Question: Reading the figure, is the described quantity rising or falling?
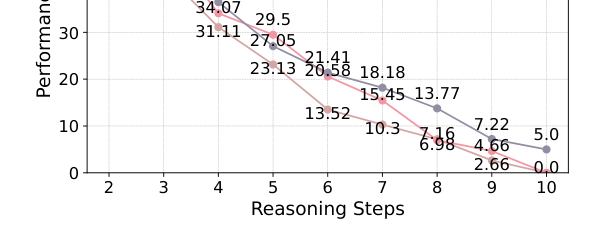
Answer: increasing